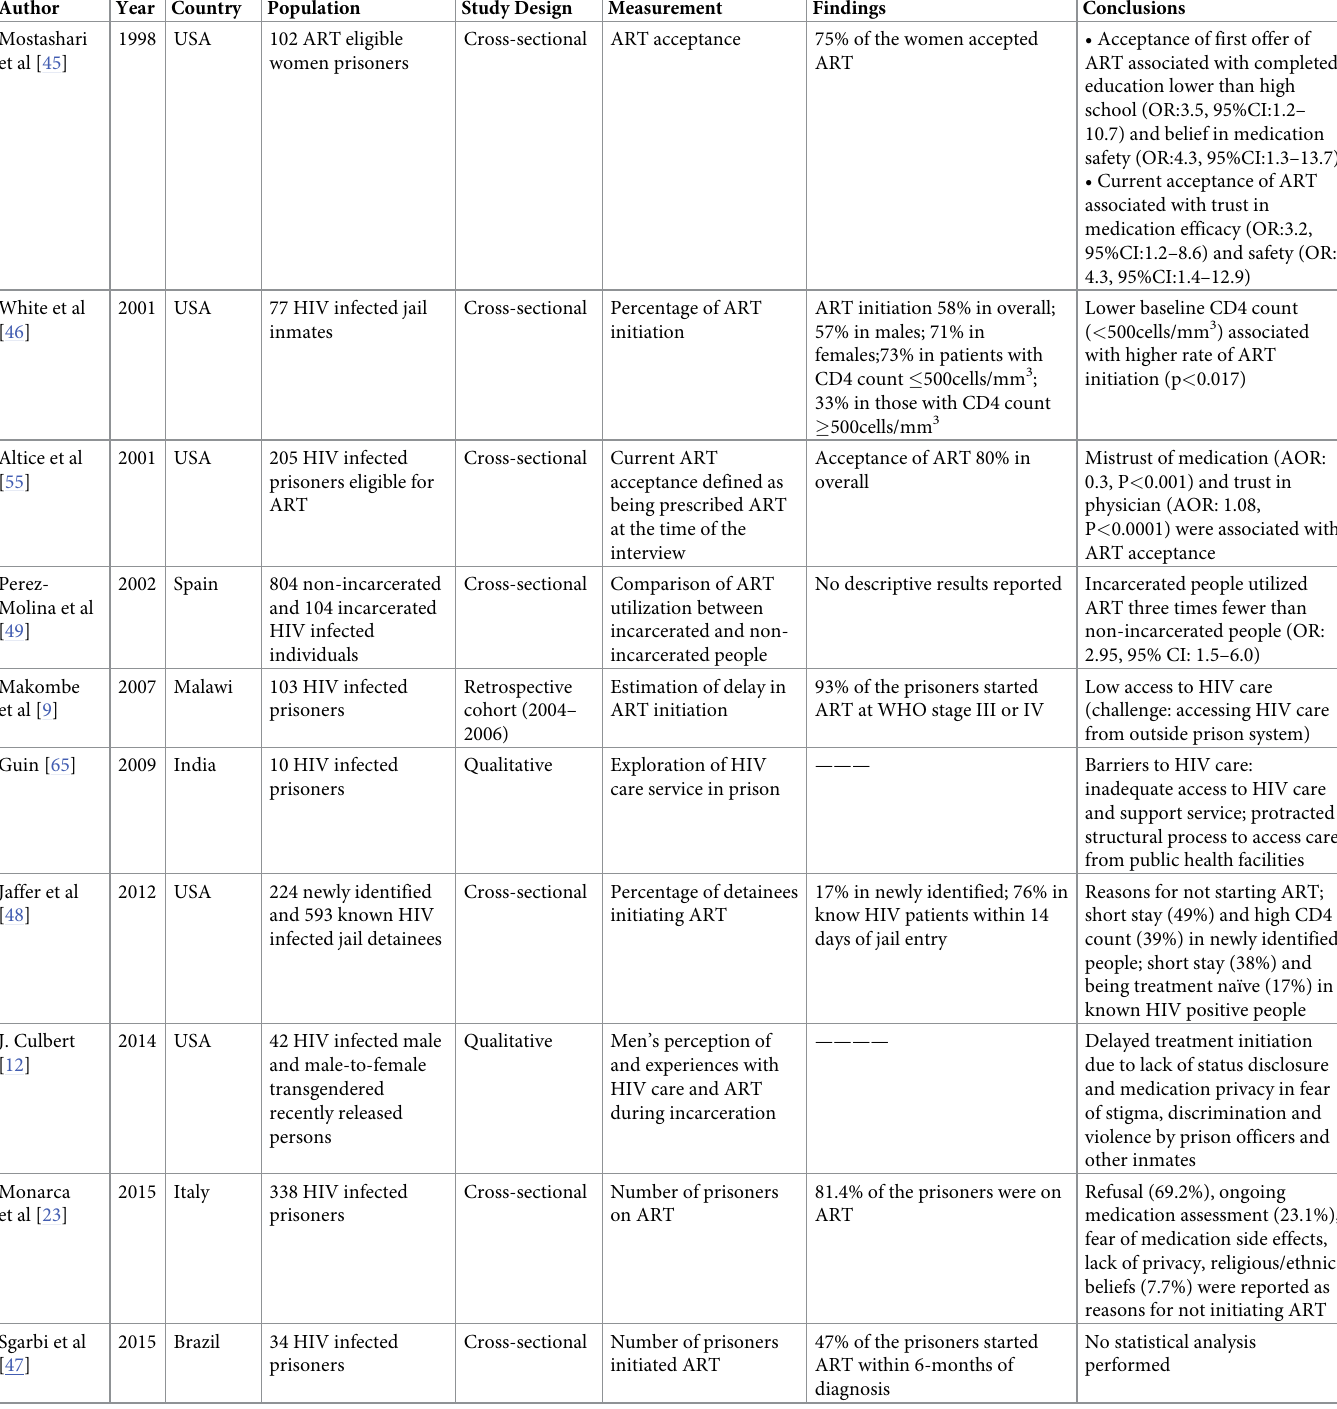
Table 1. Characteristics of studies investigating linkage to HIV care and initiation of